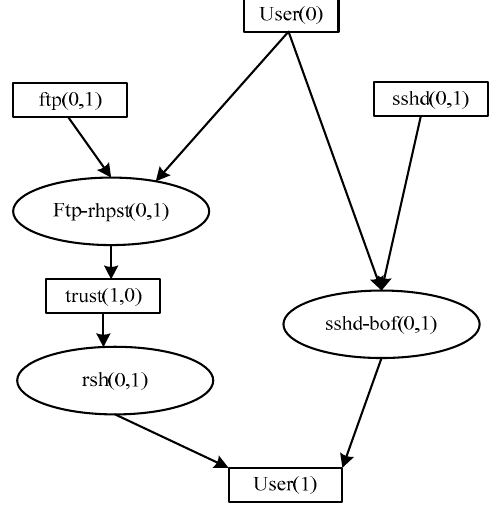
Figure 1. Attribute Attack Graph.